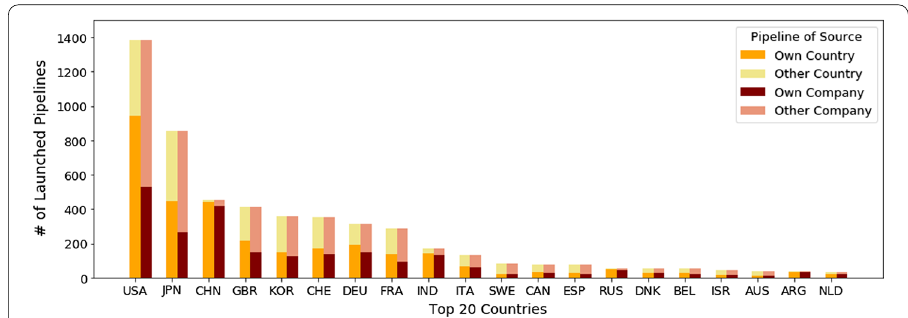
Fig. 1 The number of drug pipelines at the launched status by countries. We show the top 20 countries with self-sufficiency rates by “own country” and “own company”. “Own country” in the legend represents the number of drug pipelines discovered and launched by each country. In contrast, “other country” represents the number of drug pipelines at launched status by each country, where a different country discovers them. Similarly, “own company” in the legend represents the number of drug pipelines discovered and launched by each country. “Other company” represents the number of drug pipelines launched by each country, where they are discovered by the different companies from these